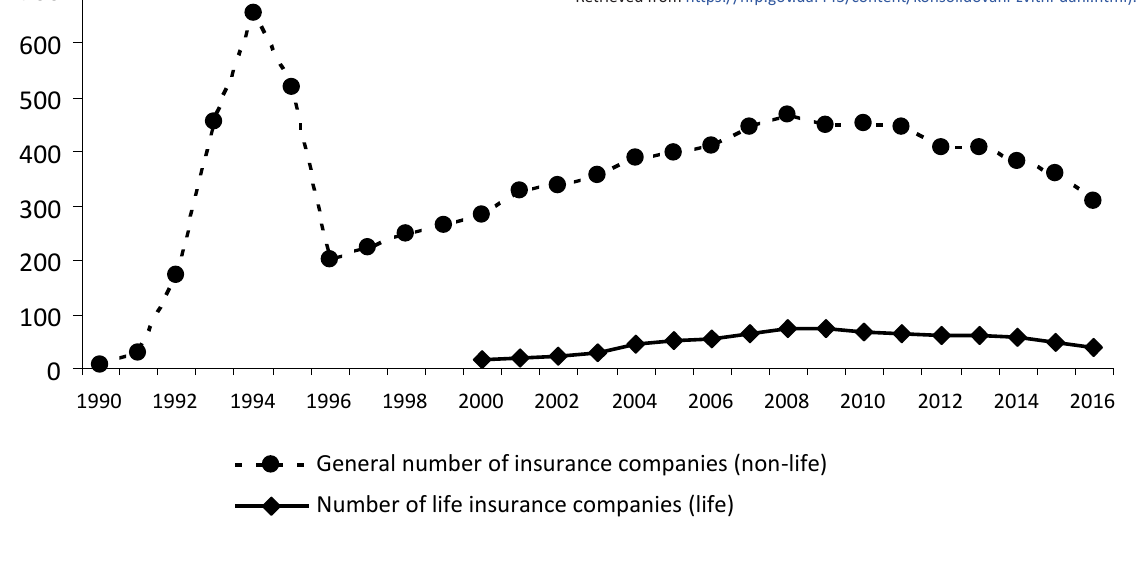
Figure 1. Dynamics of life and non-life insurance companies in Ukraine,